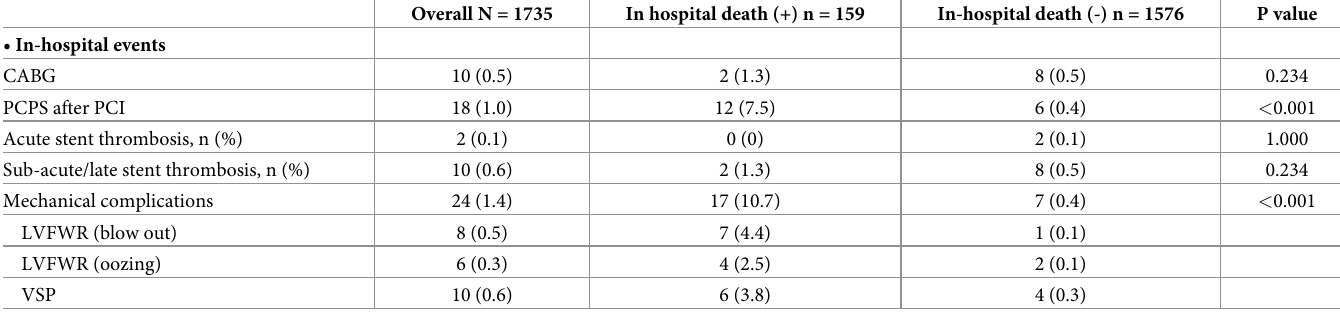
Table 2. In-hospital clinical outcomes (n =